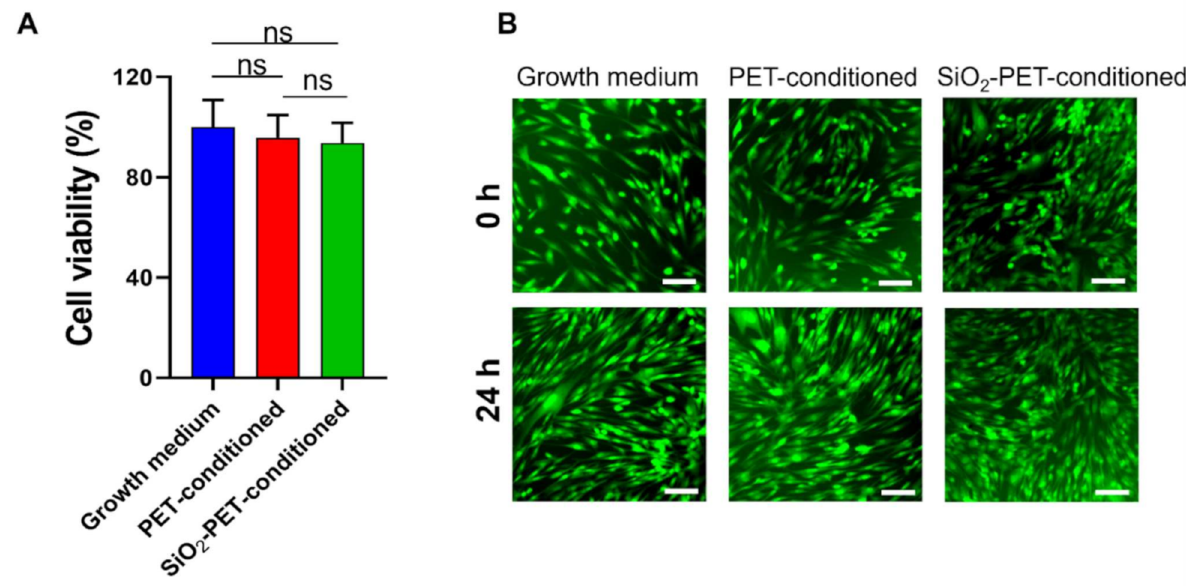
Figure 6. Cytotoxicity tests for PET and SiO 2 -deposited PET using human dermal fibroblasts (HDFs). ( A ) Cell viability after 24 h growth. ( B ) Fluorescence images of live/dead staining of HDFs at passage after 0 h and 24 h of incubation in growth medium or conditioned medium (scale bar: 100 µ m). “ns” indicates that there is no statistical